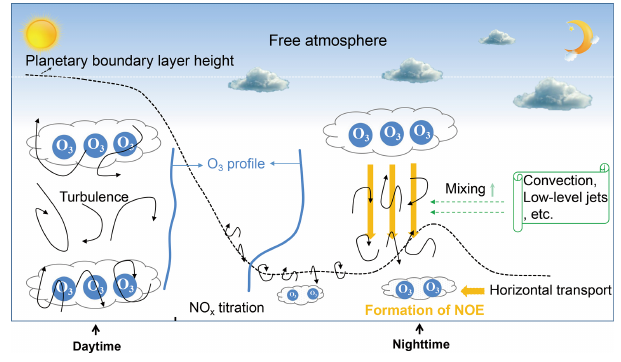
Figure 11. Conceptual model of the high frequency of NOE events over